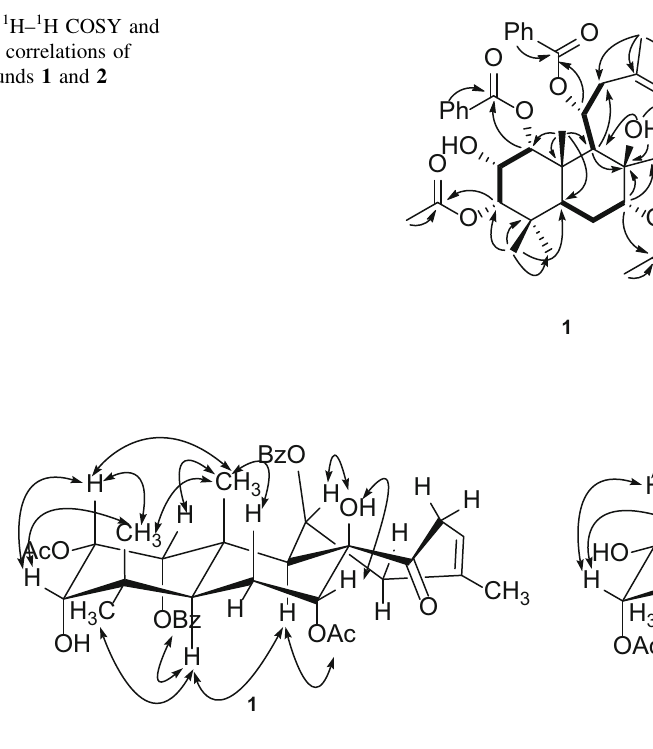
Fig. 3 ROESY correlations of compounds 1 and 2